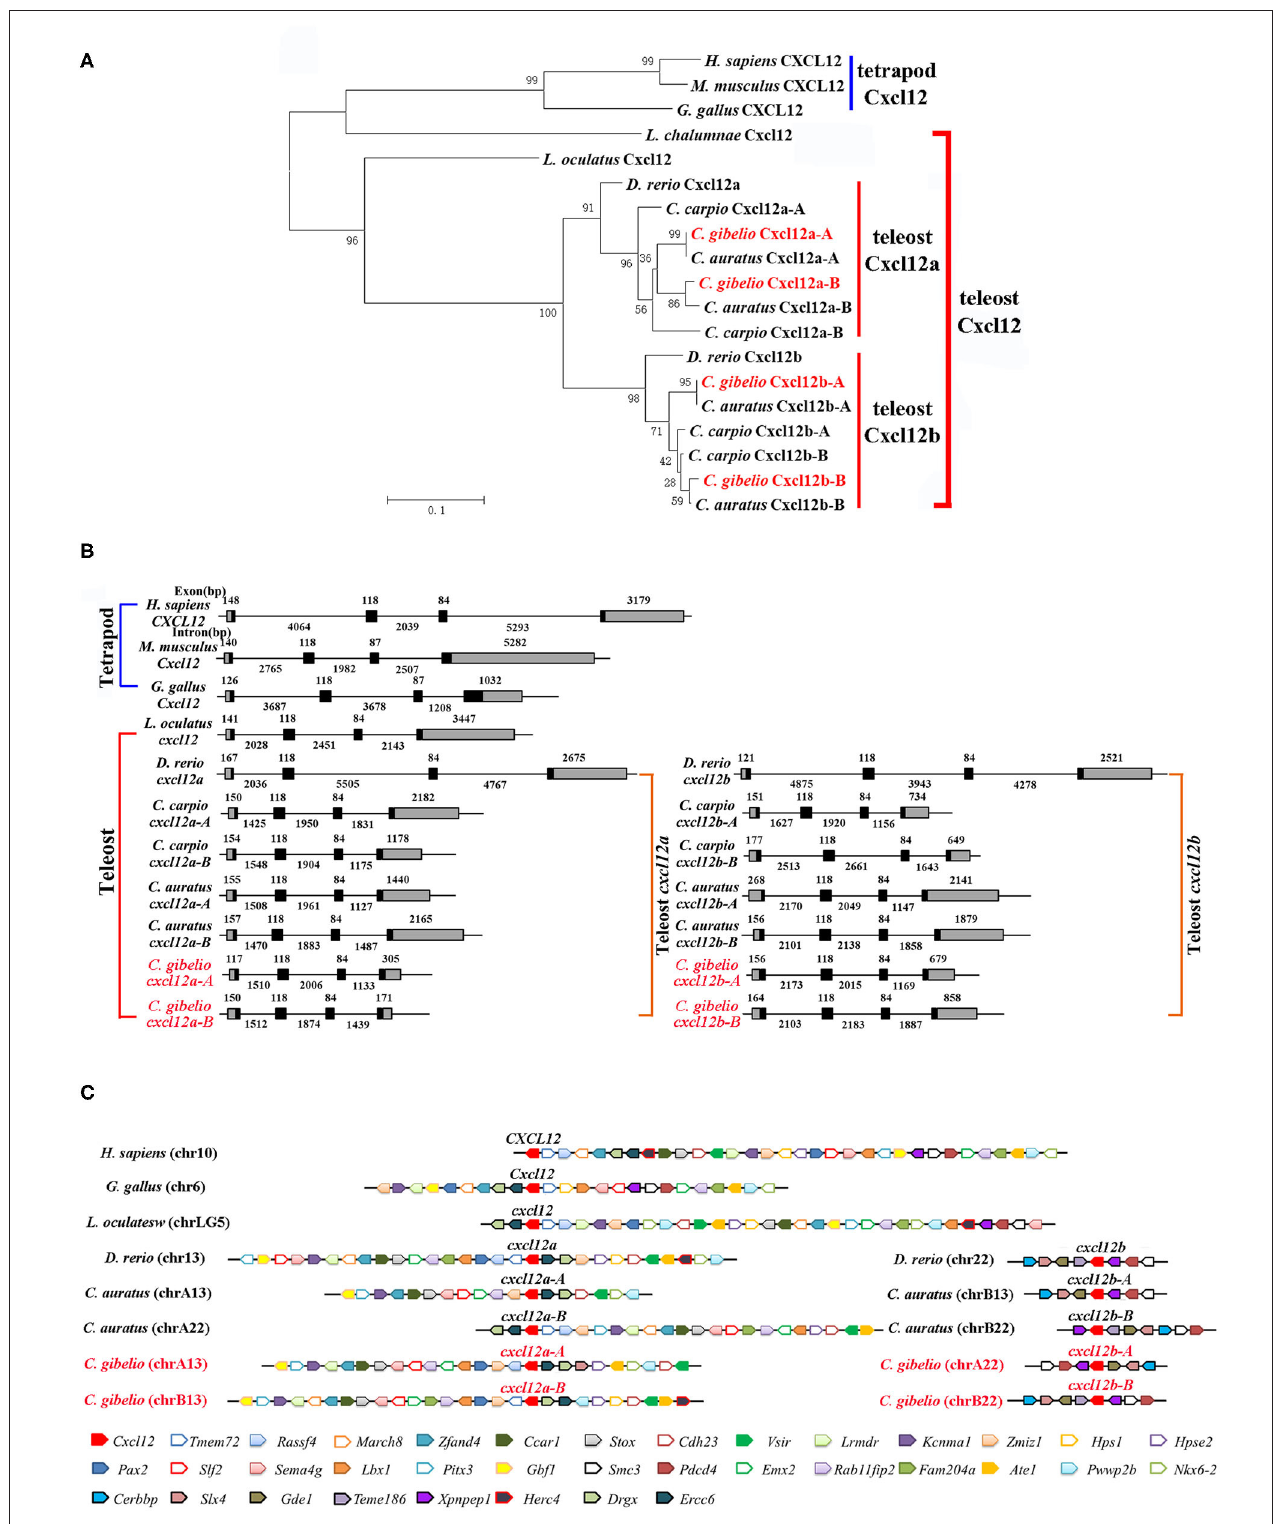
FIGURE 2 | Evolutionary analyses of multiple divergent cxcl12 genes. (A) Phylogenetic tree of Cxcl12 proteins. (B) Genomic structures of cxcl12 genes. Exons and introns are shown by boxes and horizontal lines, respectively. ORFs are highlighted by black boxes. Exon and intron size are indicated above or below as bp. (C) Syntenic alignment of chromosomal regions around cxcl12 genes. Chromosome segments are represented as thick lines. Conserved gene blocks are shown in matching colors and transcription orientations are indicated by arrows. Chr, chromosome.